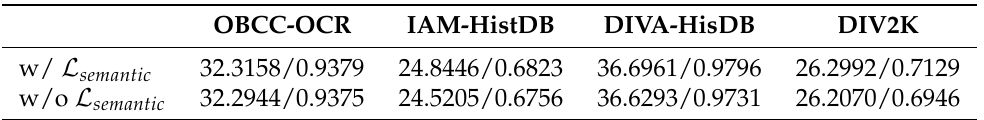
Table 1. Quality improvement of SR images with the semantic loss when training using the text image dataset (OBCC-OCR). The values to the left and right of ‘/’ represent the PSNR and SSIM,